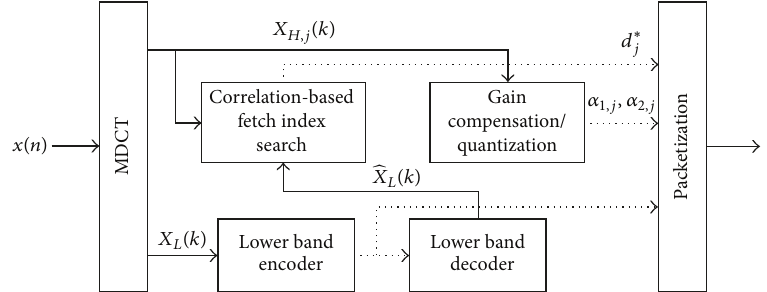
Figure 2: Structure of a conventional superwideband extension algorithm employed as the generic mode in G.729.1 Annex E [17].